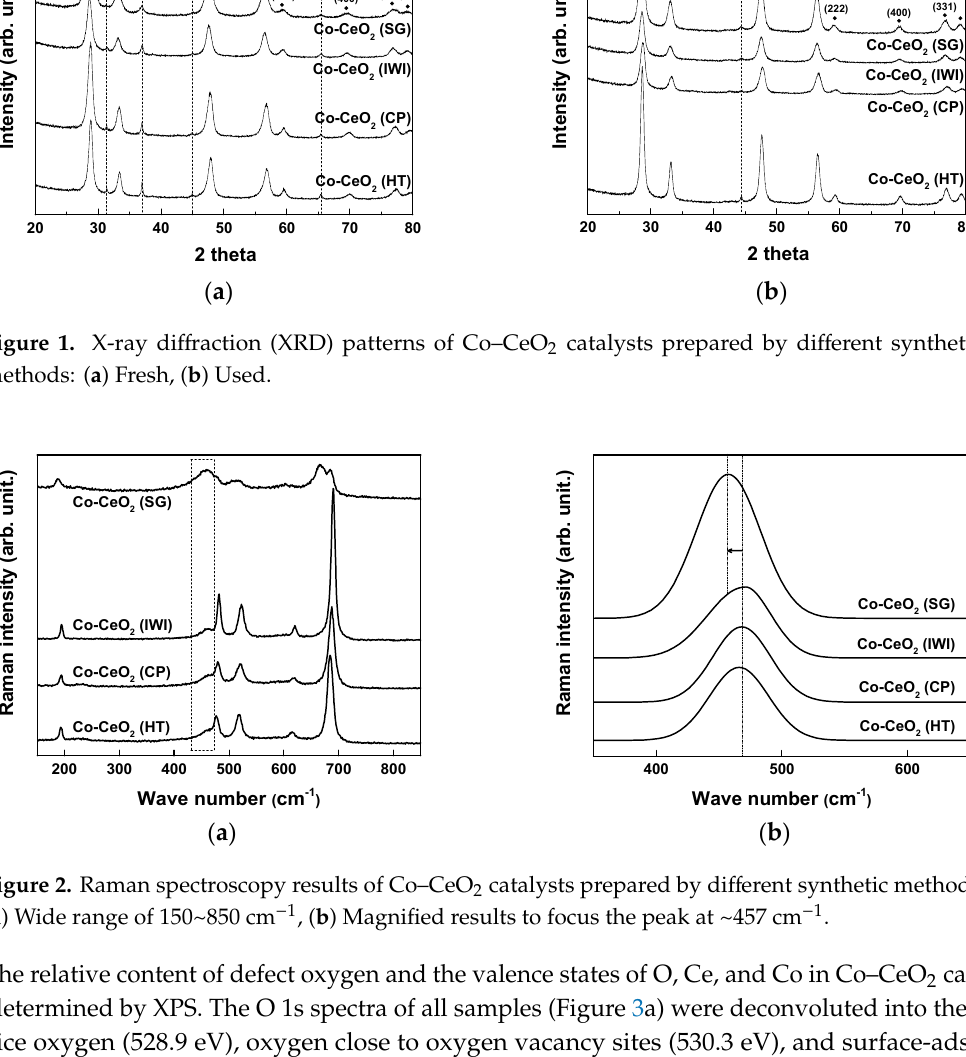
Figure 1. X-ray diffraction (XRD) patterns of Co–CeO 2 catalysts prepared by different synthetic methods: ( a ) Fresh, ( b ) Used.